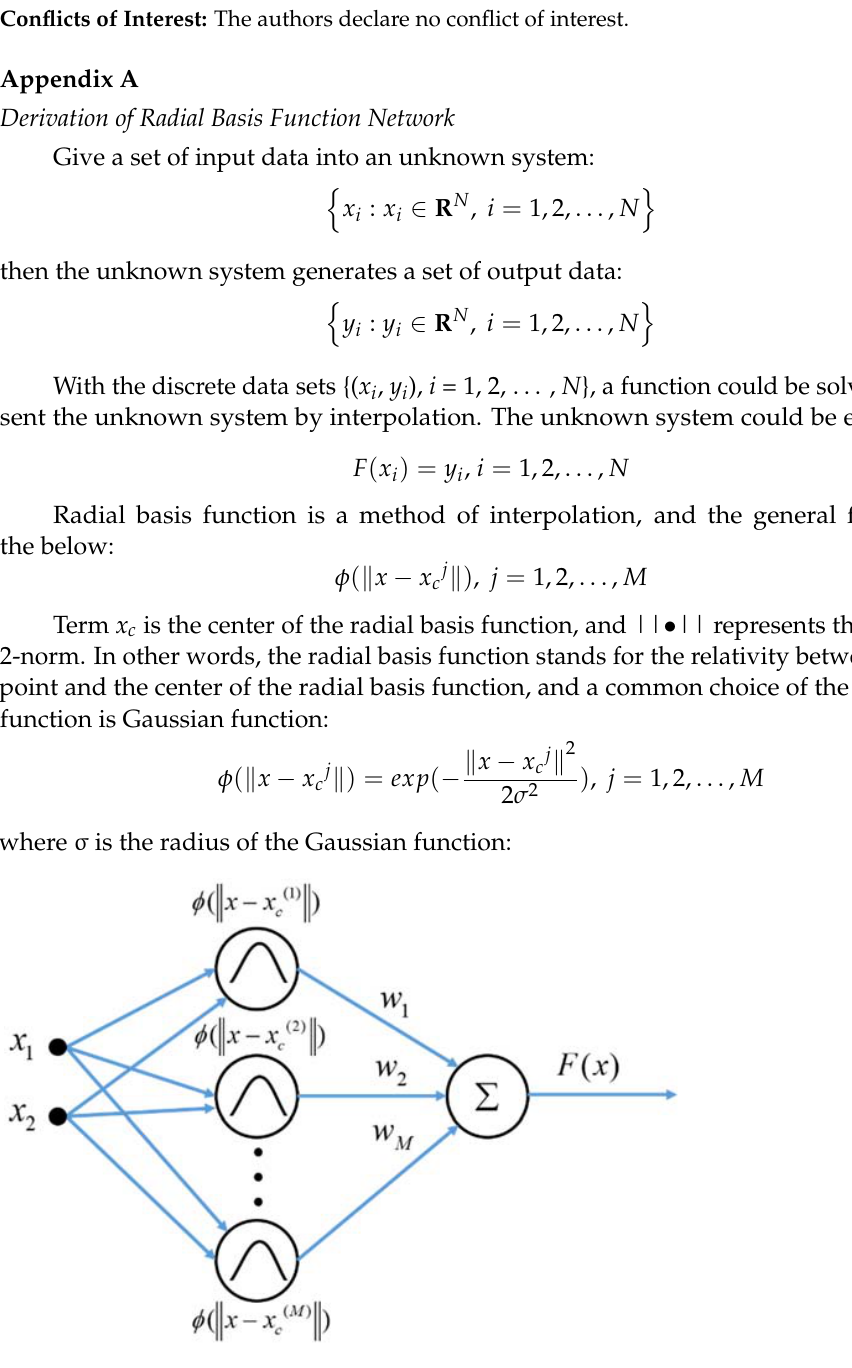
Figure A1. The concept of the radial basis function.